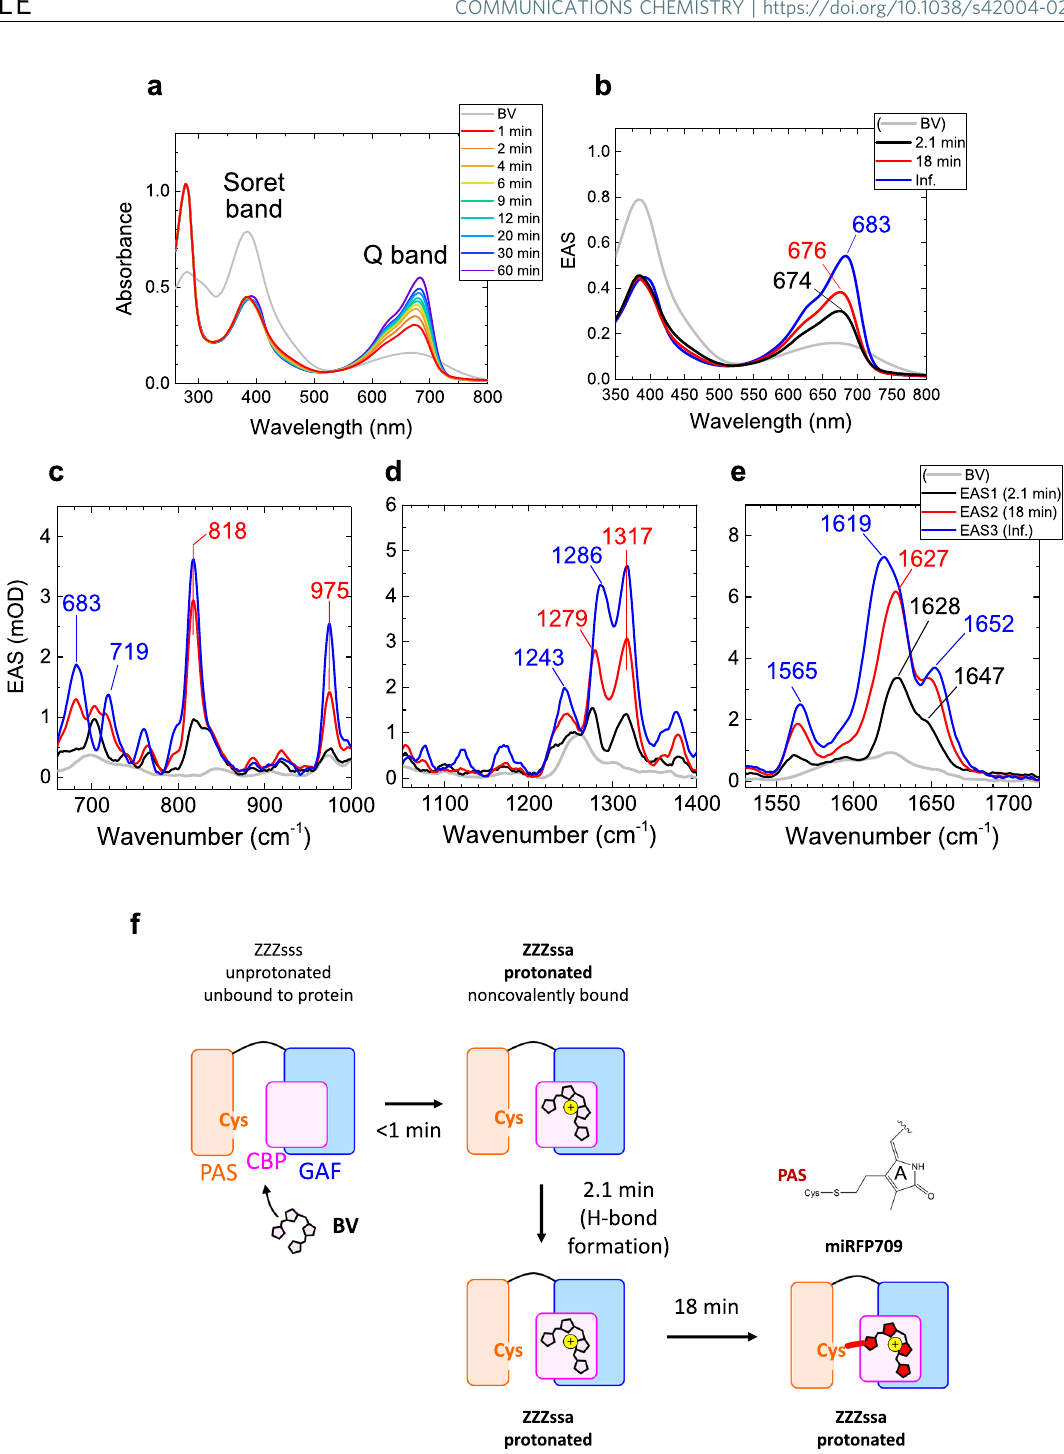
Fig. 5 Time-resolved absorption and Raman spectra of miRFP709 at pH 8.0 and biliverdin (BV) incorporation model of miRFP709. a Selected time- resolved absorption spectra. b Evolution-associated spectra (EAS) of globally fi tted time-resolved absorption spectra. c – e EAS of globally fi tted time- resolved stimulated Raman spectra with an 800 nm Raman pump. The indicated time constants denote the lifetime by which each EAS evolves into the next one. f BV incorporation model of